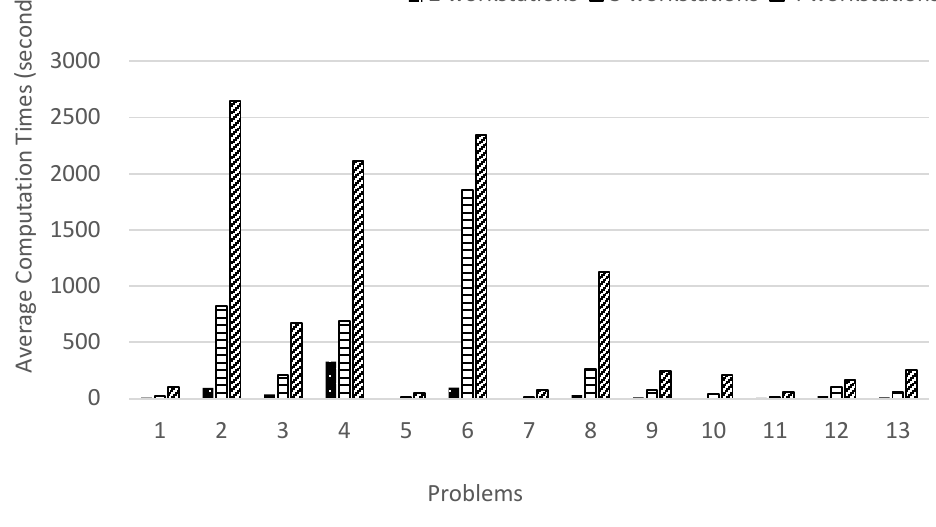
Figure 10. Computation time.